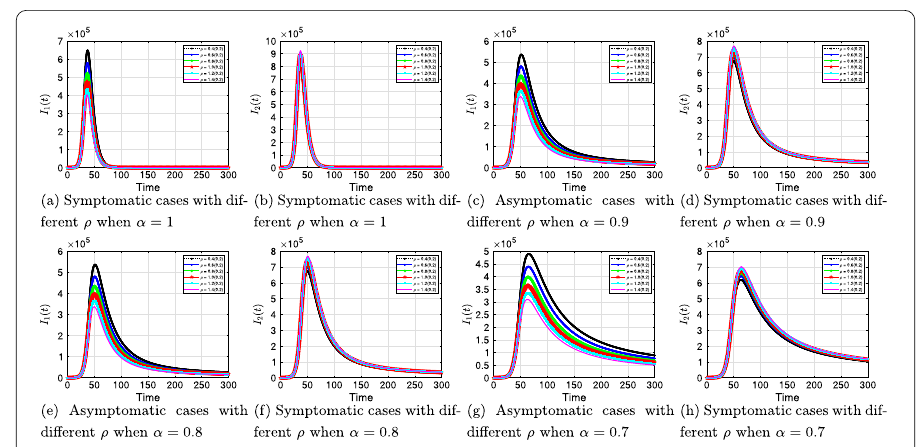
Figure 12 Solution profiles for the COVID-19 model with different ρ across different fractional order